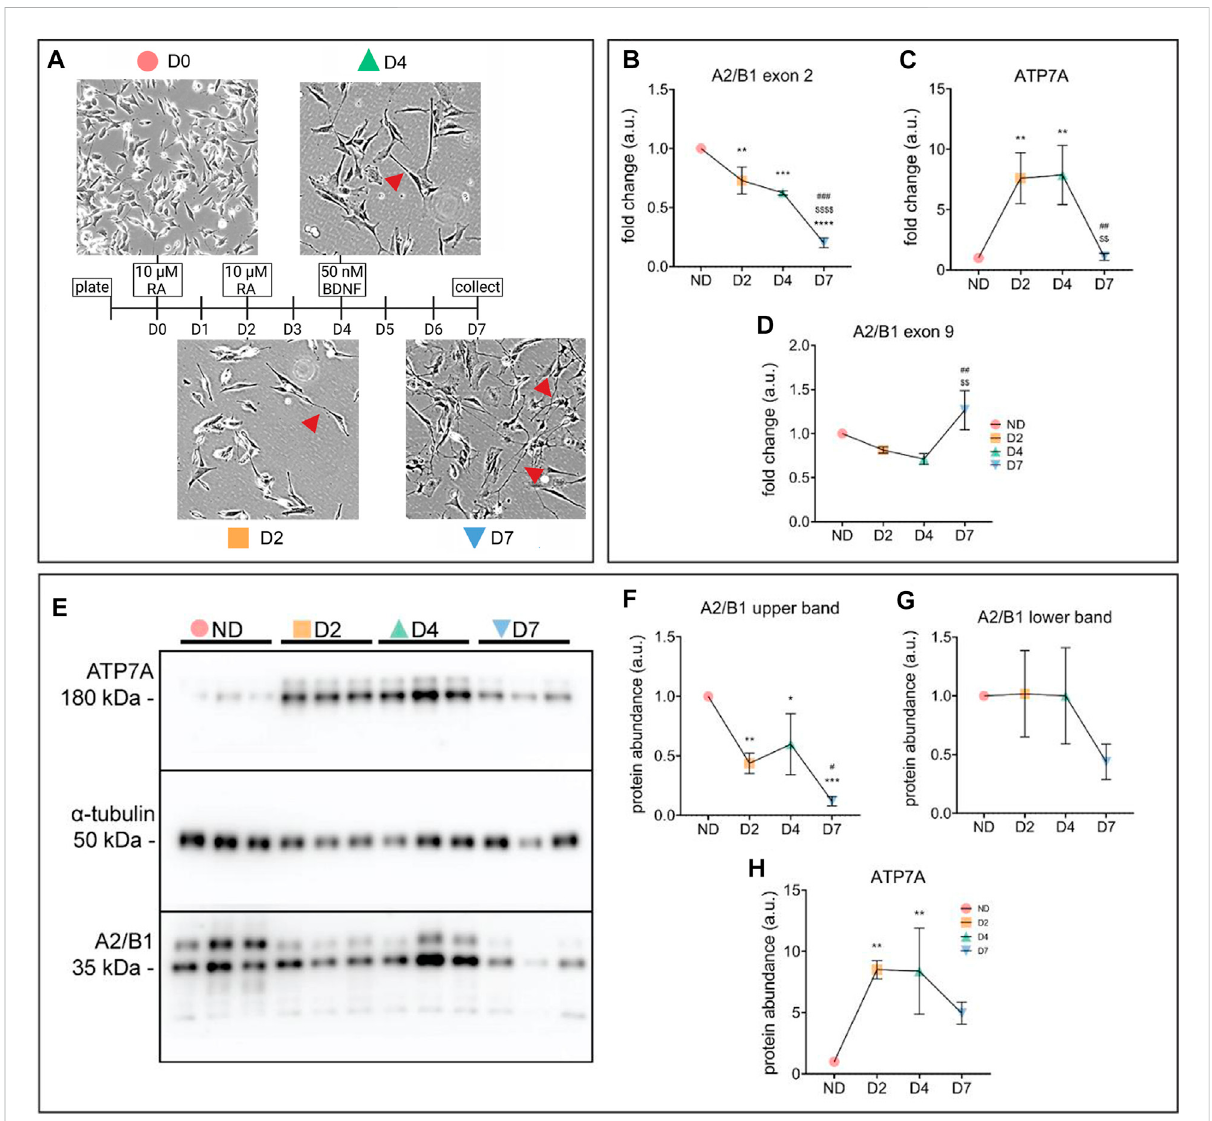
FIGURE 5 Concurrent increase of ATP7A and decrease of hnRNPA2/B1 occurs during neuronal differentiation in SH-SY5Y cells. (A) Schematic representation of SH-SY5Y differentiation using treatments with RA and BDNF. Cells were collectedfor analysis on days d0 (non-differentiated, ND), d2(differentiatedd2,D2),d4(differentiatedd4,D4),andd7(differentiatedd7,D7).MorphologicalchangesinSH-SY5Ycellsupondifferentiationwere observed via light microscopy. Neurites, an indication of neuronal maturation, are indicated with red arrowheads (B – D) qRT-PCR analysis of mRNA abundance of hnRNPA2/B1 isoforms (B,C) and ATP7A (D) . Values normalized to hS18 and ND controls, n = 3. (E) Representative Western blot showing two distinct isoforms of hnRNPA2/B1, indicated by black arrows (F – H) Densitometric analysis of protein abundance of hnRNPA2/ B1 isoforms (F,G) and ATP7A (H) . Values normalized to α -tubulin and ND controls, n = 3. All values are reported as means ± SD. Signi fi cance was determined by two-way ANOVA; * p < 0.05, ** p < 0.01, *** p < 0.001, **** p < 0.0001 compared to ND, $$$$ p < 0.001 compared to D2, and ### p < 0.001 compared to